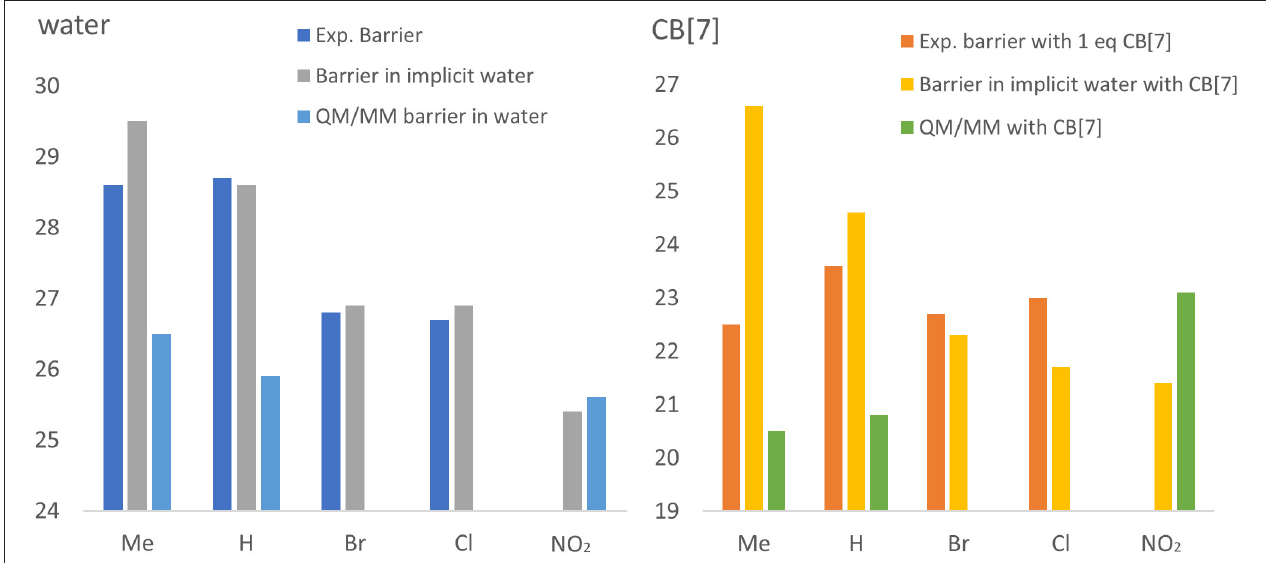
FIGURE 5 | Experimental and calculated trends for reaction barriers obtained in water (left) and catalyzed by CB[7] (right). Compounds 1b , 1a , 1c , 1d , and 1e are shown ordered in increasing electron withdrawing ability. The experimental (dark blue in water and red in CB[7]) and calculated (gray and light blue in water and orange and green in CB[7], for implicit water and QM/MM, respectively) energy barriers are shown in kcal/mol.